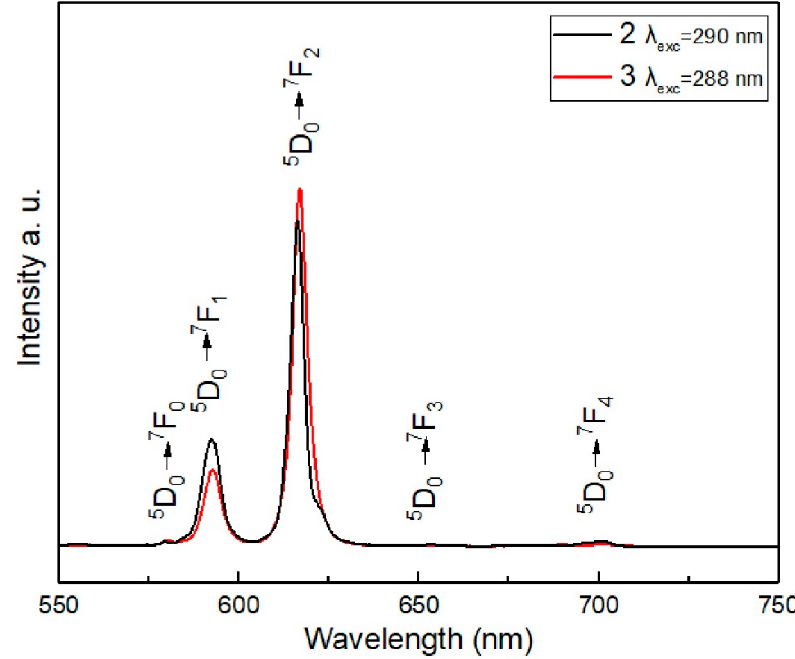
Figure 10. Emission spectrum, with λ ex = 290 nm, for 2 : [Eu(OOCC 6 H 5 ) 3 · (H 2 O) 3 ] and 3 : [Eu(OOCC 6 H 5 ) 3 · (HOOCC 6 H 5 ) 2 ].